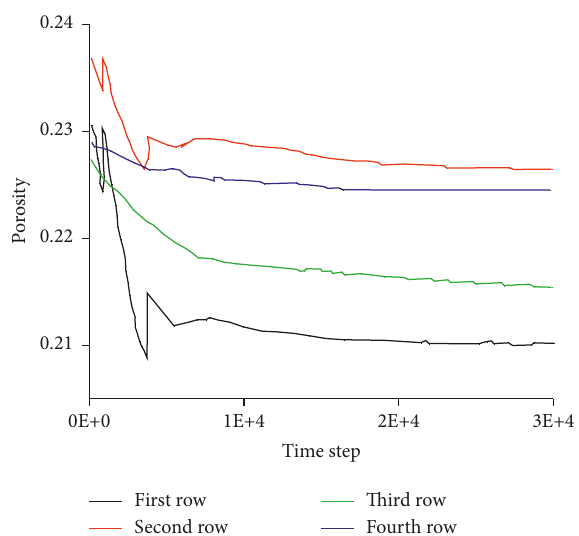
Figure 20: The porosity of upper soil particles change with in- creased load.